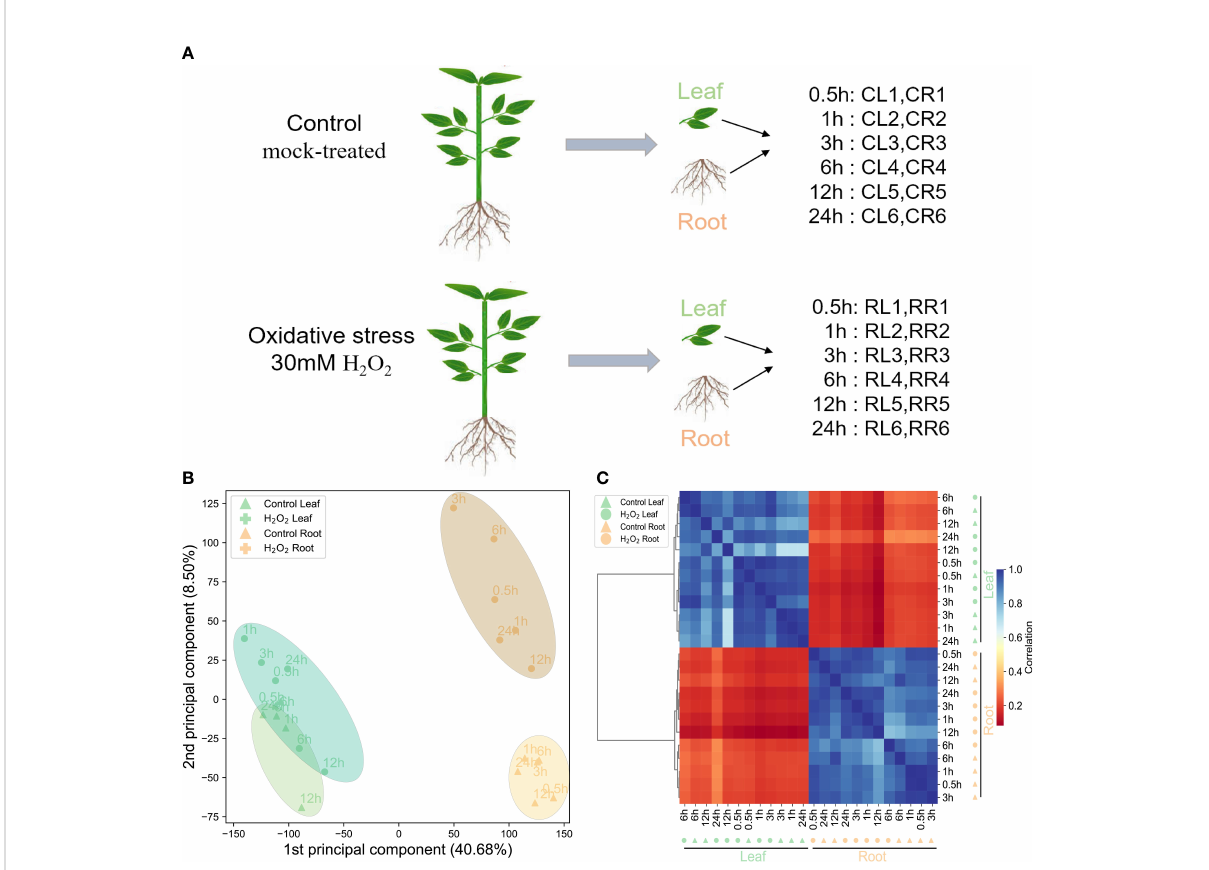
FIGURE 1 Summary of the transcriptome data of the H 2 O 2 datasets. (A) : Schematic representation of the design for the datasets. Leaf (L) and root (R) of these samples at six time points in the control and H 2 O 2 -treatment groups, respectively. (B) : Principal component analysis of the transcriptome data from the control and H 2 O 2 -treatment samples (leaf and root). (C) : The hierarchical clustering analysis of the expression pro fi les of 35,336 genes from the 24 samples; the color scale 0 – 1 represents the Pearson ’ s correlation coef fi